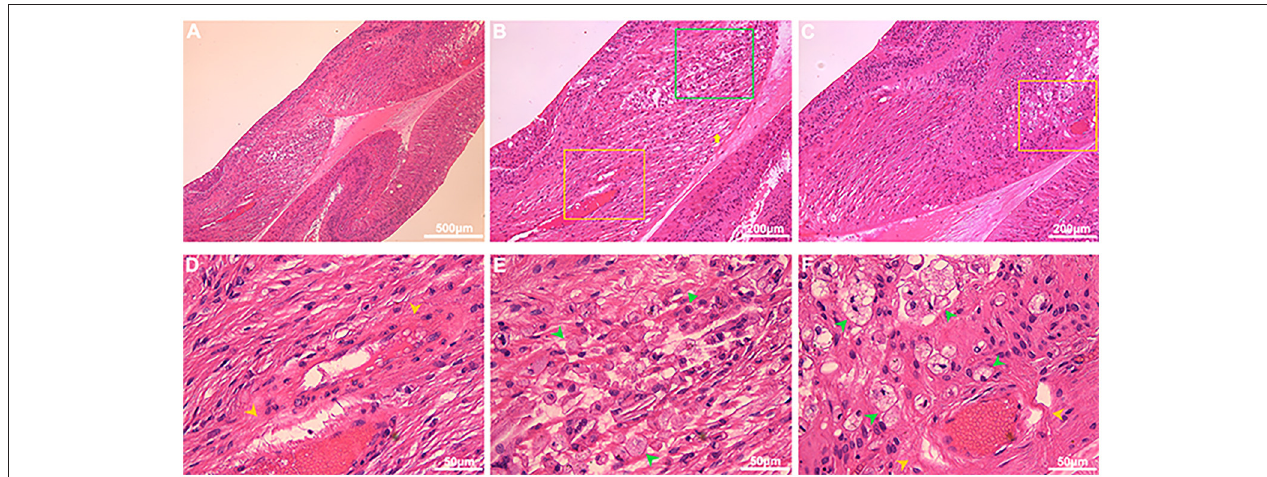
FIGURE 6 | Histopathological features in the macular region of Coats’ disease. HE staining from an enucleated eye of Coats’ disease in stage 5, which presented as whole retinal detachment. On low-power light micrographs [ (A) 5 × ; (B,C) 10 × ], dilated capillaries in the macular region (yellow boxes) were observed, and the parafoveal tissue architecture were also disrupted and replaced by hyperplastic collagen fibers (yellow arrow), infiltrated inflammatory cells and vacuoles [ (B) green box; (C) yellow boxes]. The yellow boxes in (B,C) denoting the areas with dilated capillaries were shown in the high-power micrographs [ (D,F) , respectively; 40 × ], the green box denoting the area with inflammatory cells and vacuoles was shown in the high-power micrograph [ (E) 40 × ], the vessel walls of dilated capillaries were incomplete [ (D,E) yellow arrowheads], pigment-containing macrophages (green arrowheads) and plasma cells (green triangle) were located adjacent to the dilated capillaries (E,F)